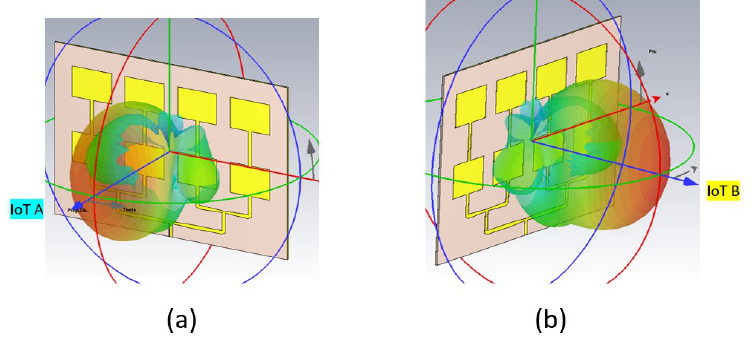
Figure 2. ( a ) Case I, ( b ) Case